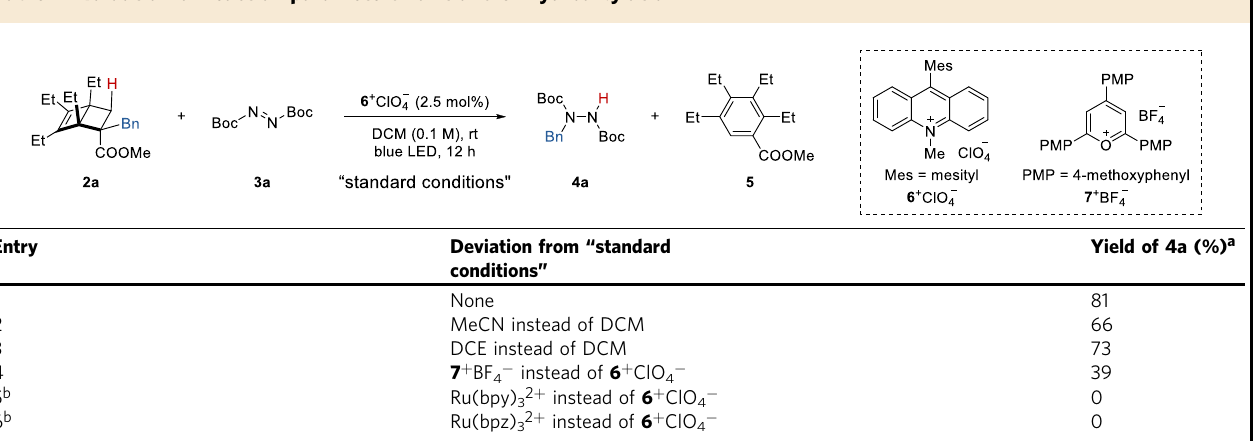
Table 1 Evaluation of reaction parameters for transfer